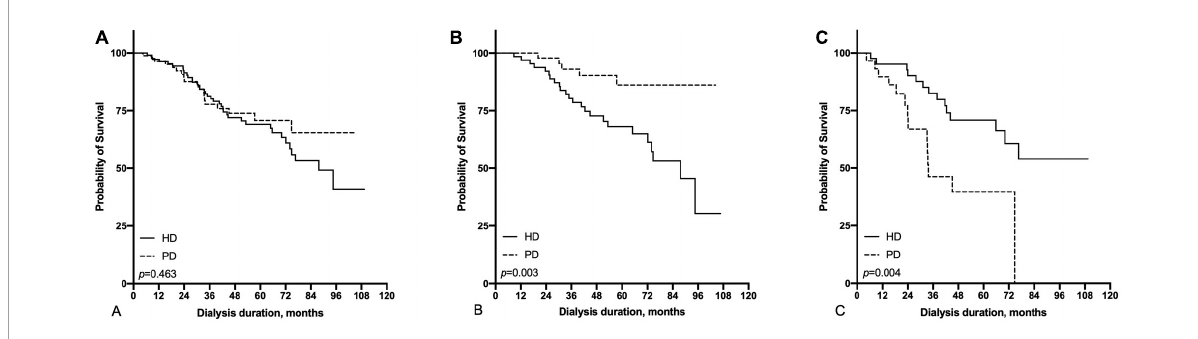
FIGURE7 Comparison of survival rate between HD and PD in the subgroup of patients with preserved LVEF ( > 55%) [ (A) all patients, (B) ≤ 65 years old group, (C) > 65 years old group].